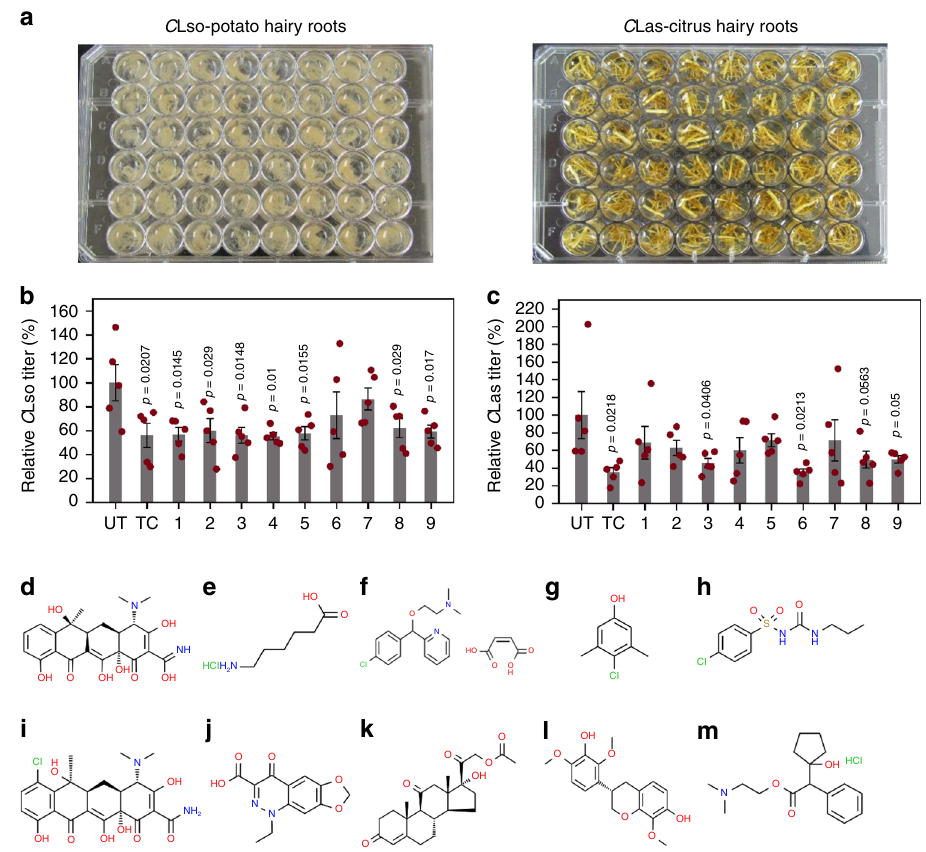
Fig. 4 High-throughput screening and identi fi cation of small molecules that confer tolerance to Candidatus Liberibacter spp. a – c Multi-well microbial hairy root culture plates were used to conduct high-throughput screening of ~220 compounds (Supplementary Dataset 1). The ef fi cacy data for nine selected hit compounds were re-assayed at 10 and 25 µ M, respectively, in a , b C Lso and a , c C Las hairy roots. Untreated (UT) and tetracycline (TC)-treated hairy roots (at 250 and 500 ppm, respectively, for the C Lso and C Las assays) were used as positive and negative controls. The bacterial titers were estimated by qPCR after 72 h of treatment with each compound and plotted relative to those of untreated samples (set to 100%). Error bars represent ± standard error of mean ( n = 5). p Values were calculated by two-sample t test (one-tailed) relative to untreated samples. d – m Chemical structures of d tetracycline and the nine hits: e aminocaproic acid (#1), f carbinoxamine maleate (#2), g chloroxylenol (#3), h chlorpropamide (#4), i chlortetracycline (#5), j cinoxacin (#6), k cortisone acetate (#7), l duartin (#8), and m cyclopentolate hydrochloride (#9). The structures of the different chemical compounds were retrieved from the ChemSpider database (http://www.chemspider.com/) (last accessed on 15 October 2020). Source data underlying Fig. 4b, c are provided as a Source Data fi